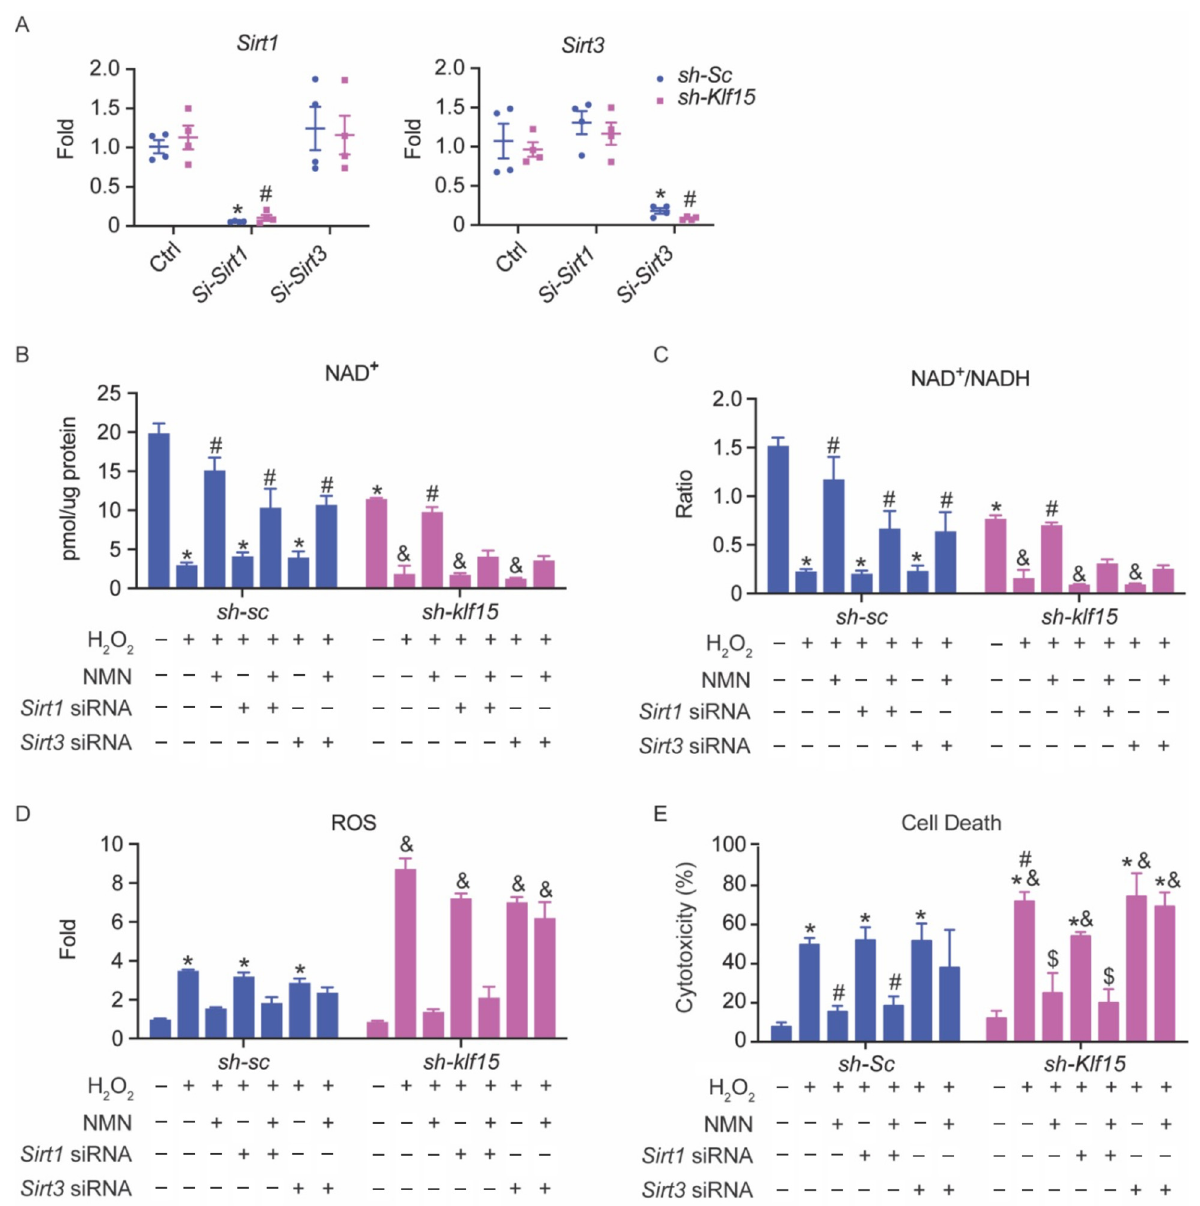
Figure 4. The cardioprotective effect of NMN in oxidative stress is SIRT3-dependent. NRVMs with shRNA knockdown of scrambled RNA ( sh-Sc ) or Klf15 ( sh-Klf15 ) were transfected with 25 nM Sirt1 , Sirt3 siRNA, or negative control siRNA for 48 h. ( A ) qPCR analysis of Sirt1 and Sirt3 levels in NRVMs ( n = 4, *: p < 0.001 vs. NRVM transfected with negative control siRNA and sh-Sc ; #: p < 0.001 vs. NRVM transfected with negative control siRNA and sh-Klf15 ). ( B ) NRVMs were pretreated with 2 mM NMN or PBS for 24 h prior to exposure to 100 µ M H 2 O 2 for 90 min. ( B ) NAD + level. ( C ) NAD + /NADH ratio. ( D ) ROS was measured by DHE fluorescence intensity in a microplate reader, with excitation at 485 nm and emission at 590 nm. The fluorescence intensity was normalized to total protein in each sample. ( E ) Percentage of cytotoxicity was derived from LDH assay. ( n = 3–4, *: p < 0.01 vs. sh-Sc without treatment; #: p < 0.05 vs. sh-Sc treated with H 2 O 2 ; &: p < 0.01 vs. sh-Klf15 without treatment; $: p < 0.05 vs. sh-Klf15 treated with H 2 O 2 ). Two-way ANOVA with Bonferroni correction was used to determine statistic difference. Data are presented as mean ±